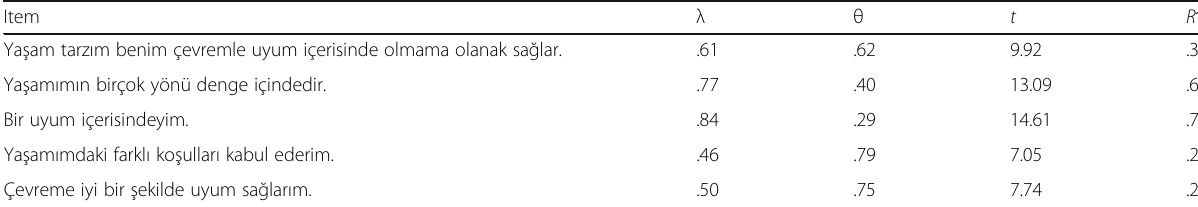
Table 1 CFA results of Turkish-HiL Item